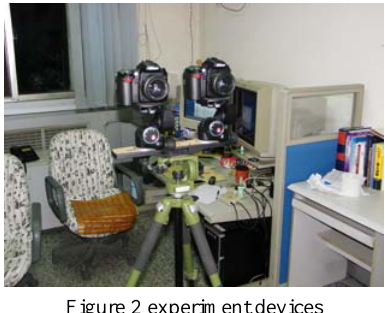
Figure 2 experiment devices